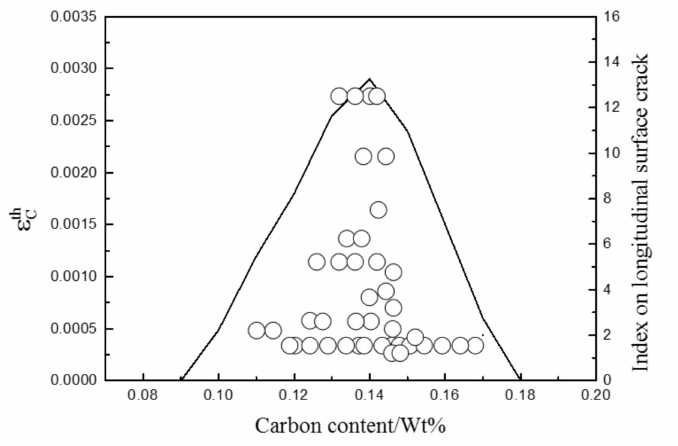
Figure 4. Measured index on longitudinal surface crack and calculated strain during the peritectic phase transformation in the brittle temperature range (ZDT < T B <